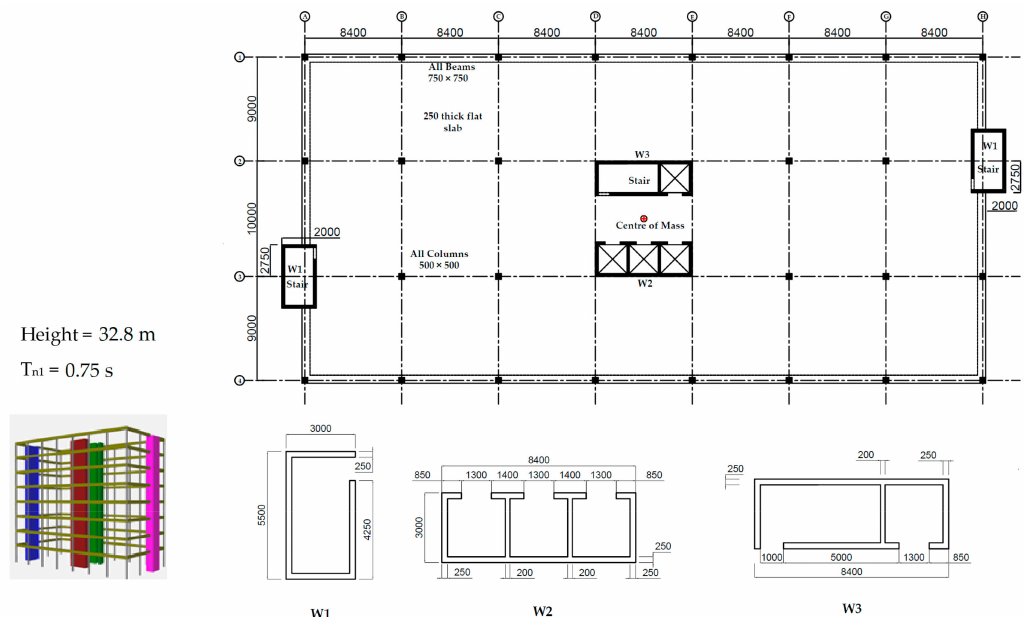
Figure 12. Floor plan, structural layout, and elevation view of CSB 2 (all dimensions are in mm) [28].